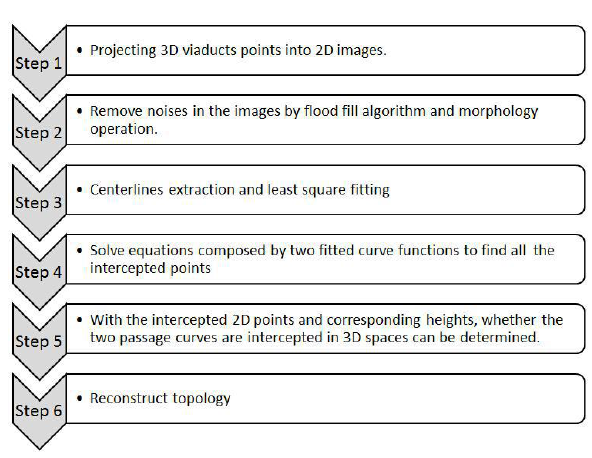
Figure 7. Reconstruction Flow